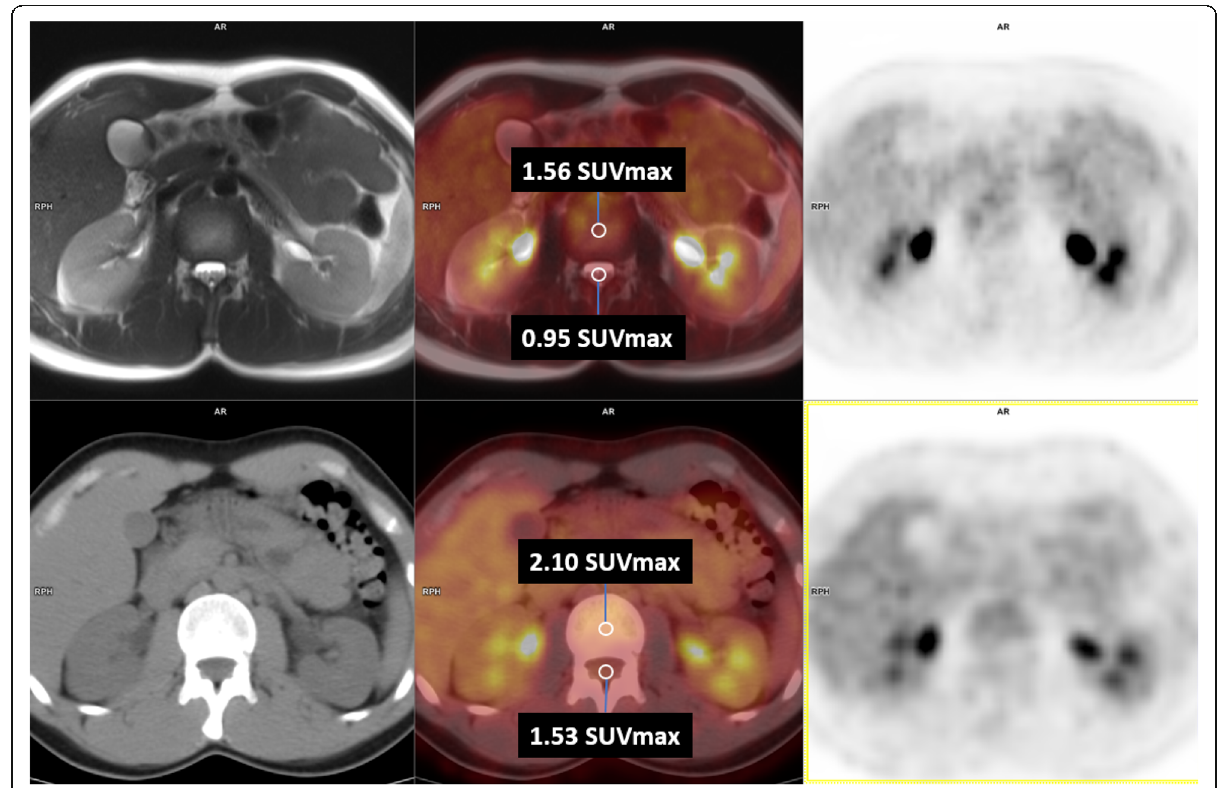
Fig. 1 Example of a 3 mm radius ROI at T12 level. The ROI was centered on the spinal cord and the corresponding vertebral body bone marrow. Top row from left to right (MRI, PET/MRI, PET); bottom row from left to right (CT, PET/CT,